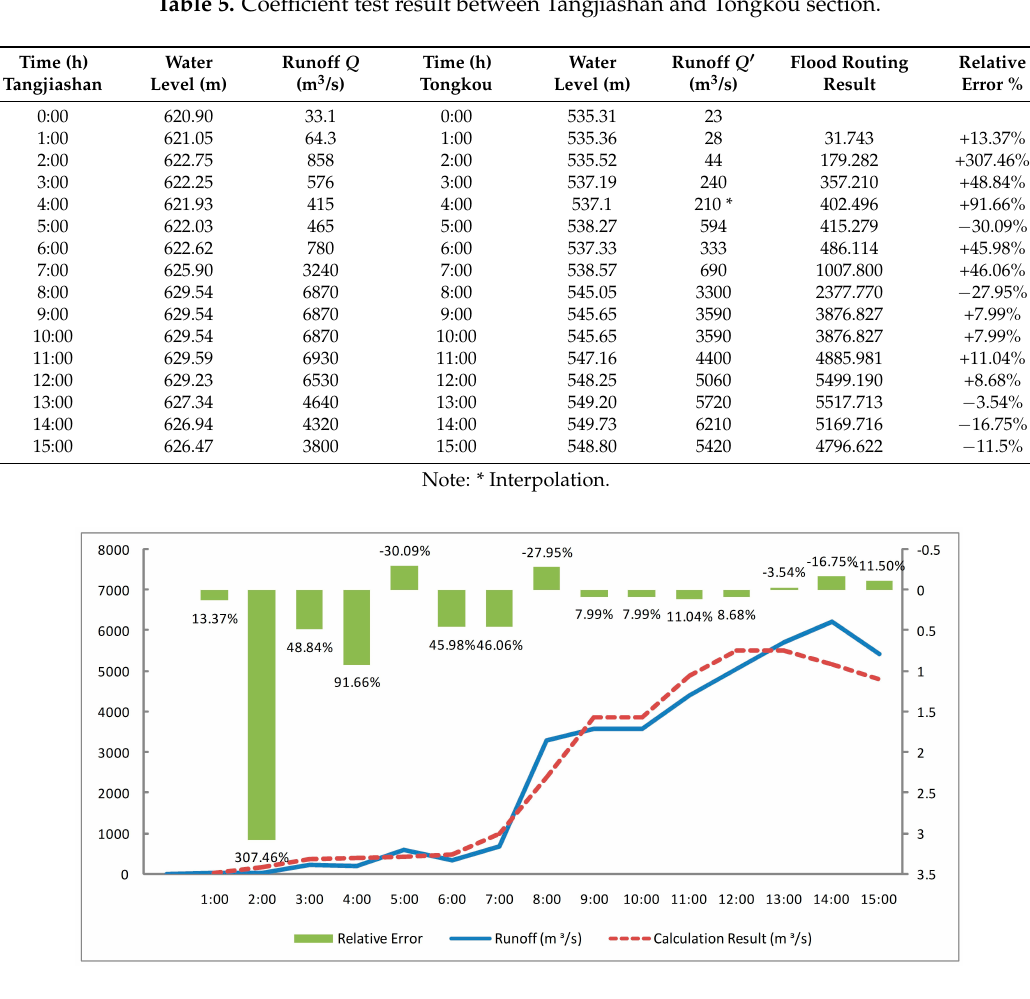
Table 5. Coefficient test result between Tangjiashan and Tongkou section.